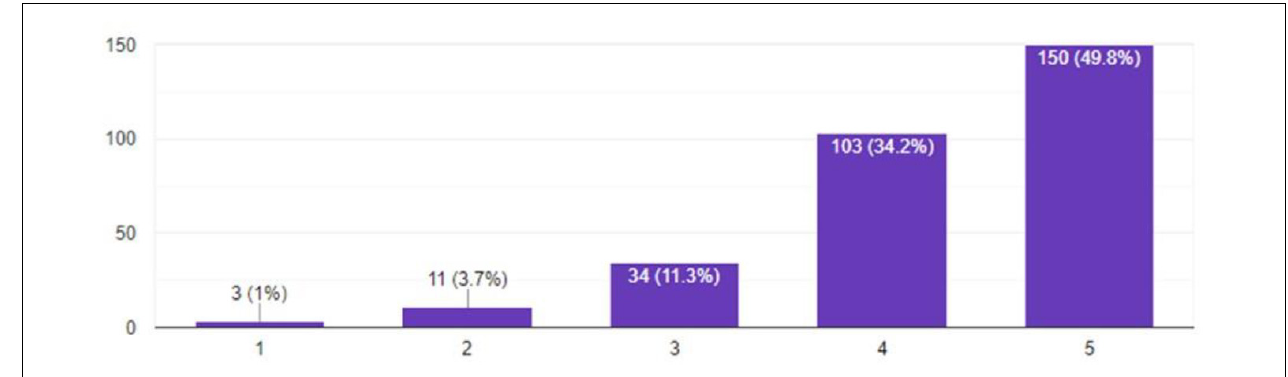
FIGURE 2 | Bills during remote working.